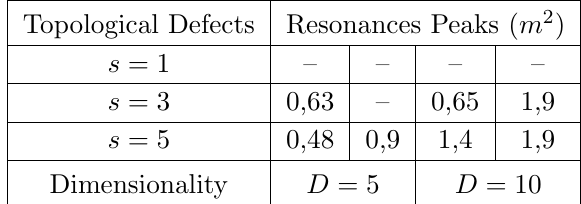
Table 2 . Peaks of resonances for massive right handed fermions.